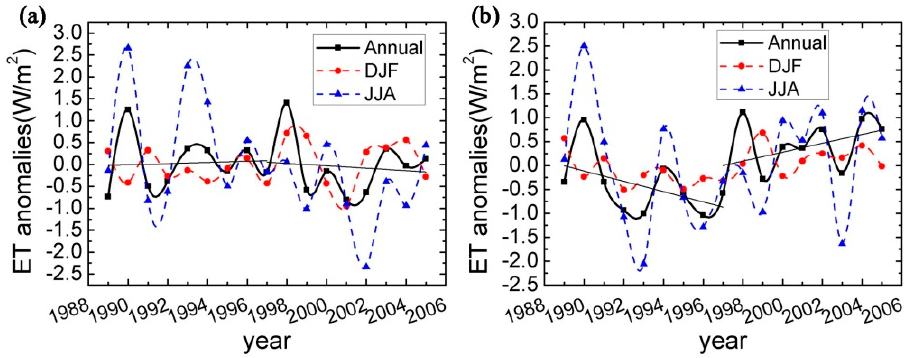
Figure 8. The evolution of ET anomalies in the water-control ( a ) and energy-control ( b ) regions. The black solid lines represent the annual average anomalies, the red dotted lines show the winter averages, and the blue dotted lines indicate the summer averages. The black line segments are the lines fitted to the ET anomalies before and after 1998.